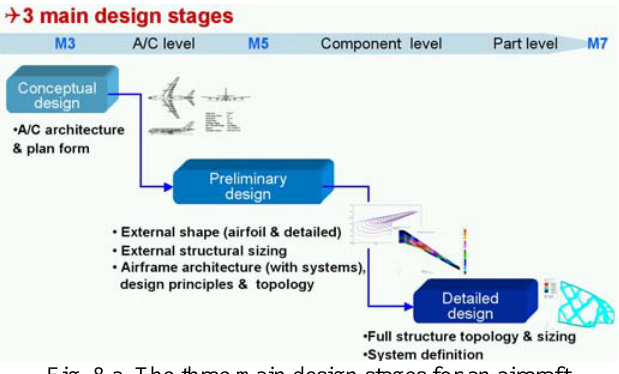
Fig. 8.a. The three main design stages for an